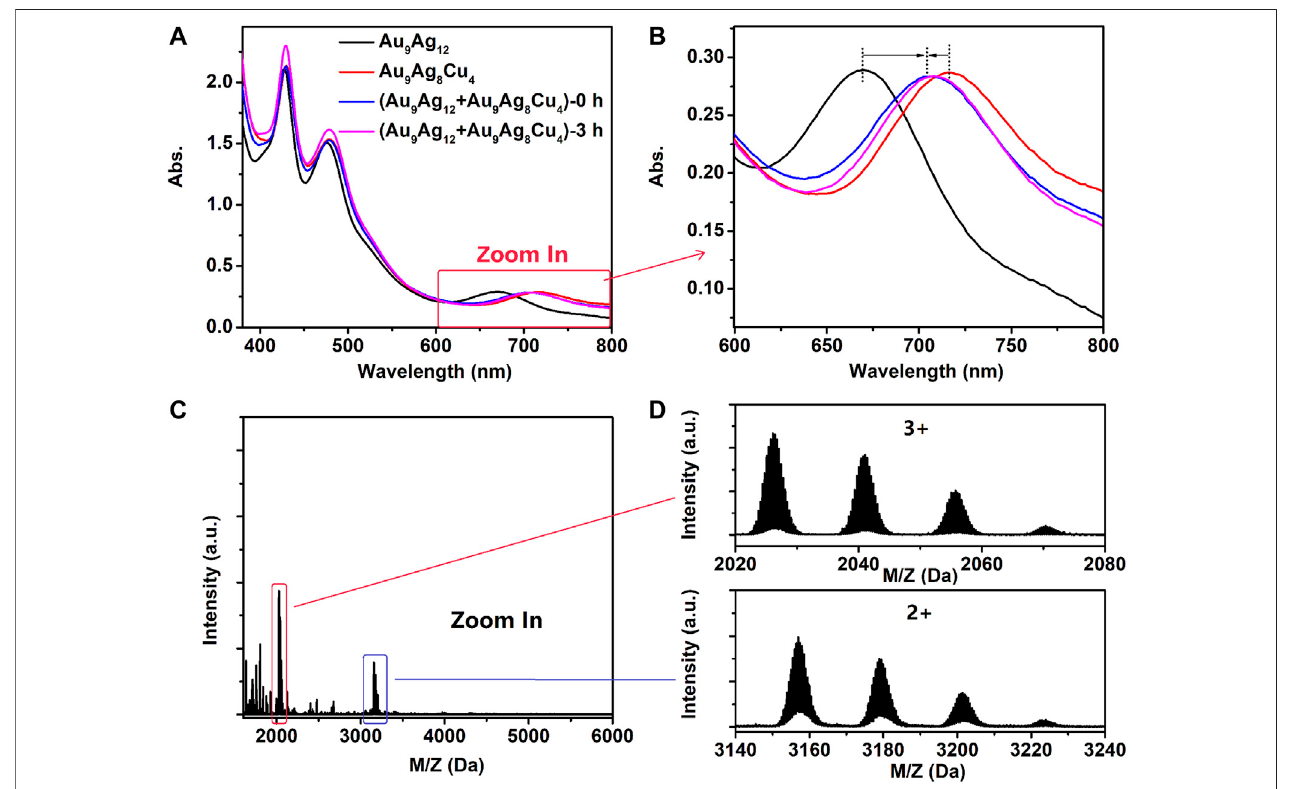
FIGURE7|(A,B) theUV-visspectraofinterclusterreactionbetween[Au 9 Ag 12 (SAdm) 4 (Dppm) 6 Cl 6 ](SbF 6 ) 3 and[Au 9 Ag 8 Cu 4 (SAdm) 4 (Dppm) 6 Cl 6 ](SbF 6 ) 3 and (C,D) the ESI-MS spectra after reacting 3 h. For the top spectra of Figure 4D , the peaks with +3 charge indicate the [Au 9 Ag 8 Cu 4 (SAdm) 4 (Dppm) 6 Cl 6 ] 3+ , [Au 9 Ag 9 Cu 3 (SAdm) 4 (Dppm) 6 Cl 6 ] 3+ , [Au 9 Ag 10 Cu 2 (SAdm) 4 (Dppm) 6 Cl 6 ] 3+ and [Au 9 Ag 11 Cu 1 (SAdm) 4 (Dppm) 6 Cl 6 ] 3+ . And For the bottom spectra of Figure 4D , the peaks with +2 charge indicate the {[Au 9 Ag 8 Cu 4 (SAdm) 4 (Dppm) 6 Cl 6 ]+(SbF 6 )} 2+ , {[Au 9 Ag 9 Cu 3 (SAdm) 4 (Dppm) 6 Cl 6 ]+(SbF 6 )} 2+ , {[Au 9 Ag 10 Cu 2 (SAdm) 4 (Dppm) 6 Cl 6 ]+(SbF 6 )} 2+ and {[Au 2+ 9 Ag 11 Cu 1 (SAdm) 4 (Dppm) 6 Cl 6 ]+(SbF 6 )}